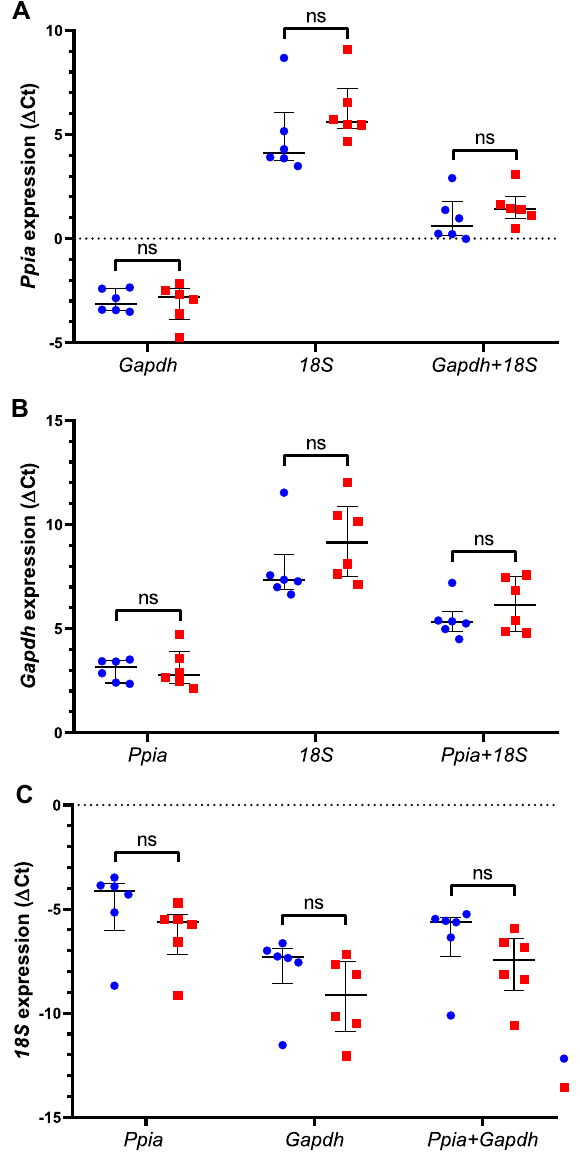
Figure 3. The ΔCt values of Ppia ( A ), Gapdh ( B ) and 18S ( C ) candidate housekeeping genes were normalized by combinations of each other. A negative ΔCt value indicates that the target gene is more abundant than the HKG. The median values are expressed as horizontal lines, and the error bars represent the interquartile range. Ppia , target expression normalized by Gapdh , 18S and Gapdh + 18S ; Gapdh , target expression normalized by Ppia , 18S and Ppia + 18S ; 18S , target expression normalized by Ppia , Gapdh and Ppia + Gapdh . ns, non-